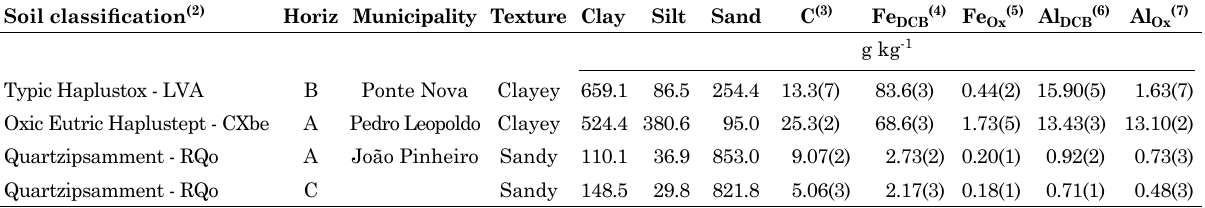
Table 2. Identification, sampling site, and some chemical and physical (textural analysis) characteristics of soils used as a support for calibration curves (1) Soil classification